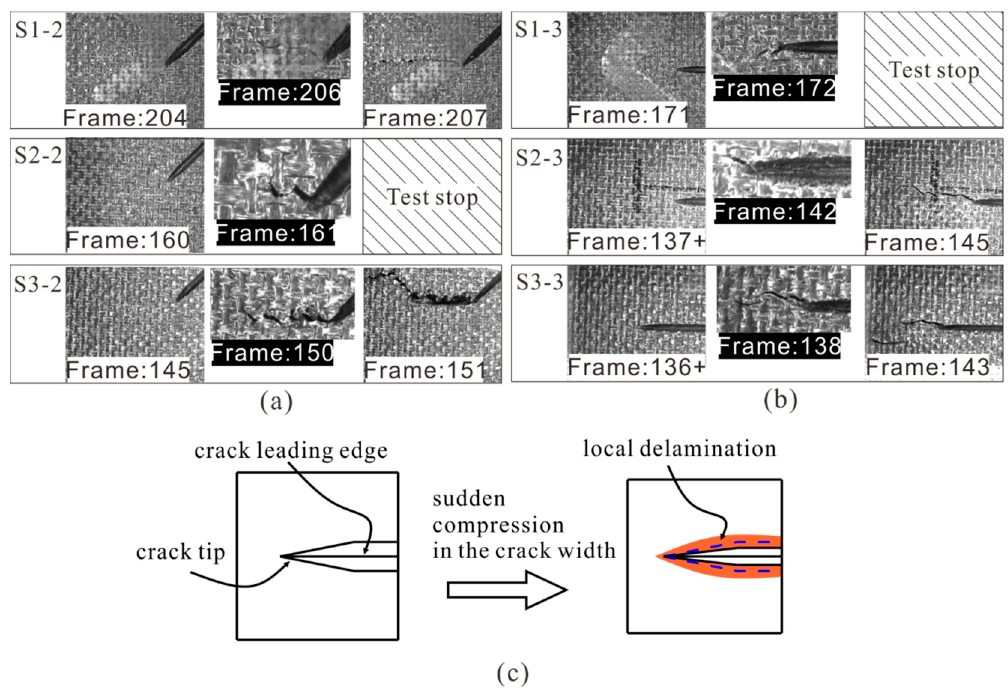
Figure 10. ( a ) 45° and ( b ) 90° shallow surface cracks propagation under compression; ( c ) illustration of the “sudden compression” phenomenon.